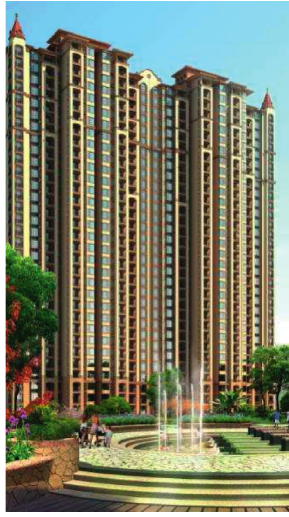
Figure 2: The high-rise residential building.